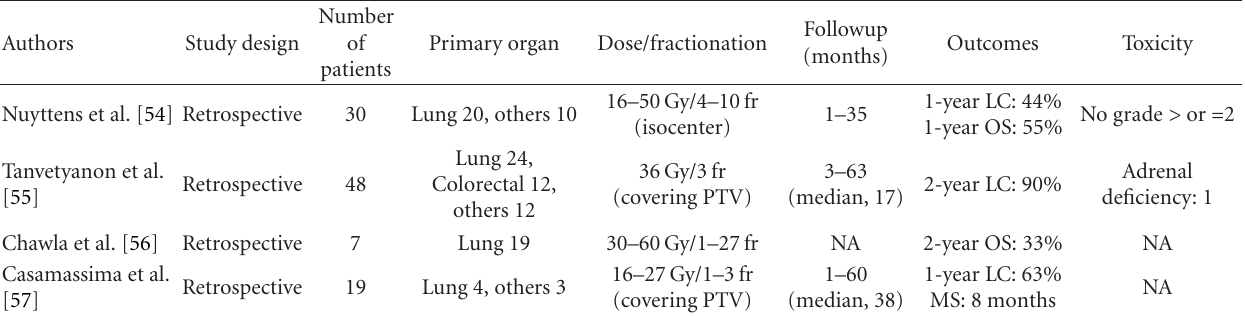
Table 2: Reports of stereotactic body radiotherapy for adrenal